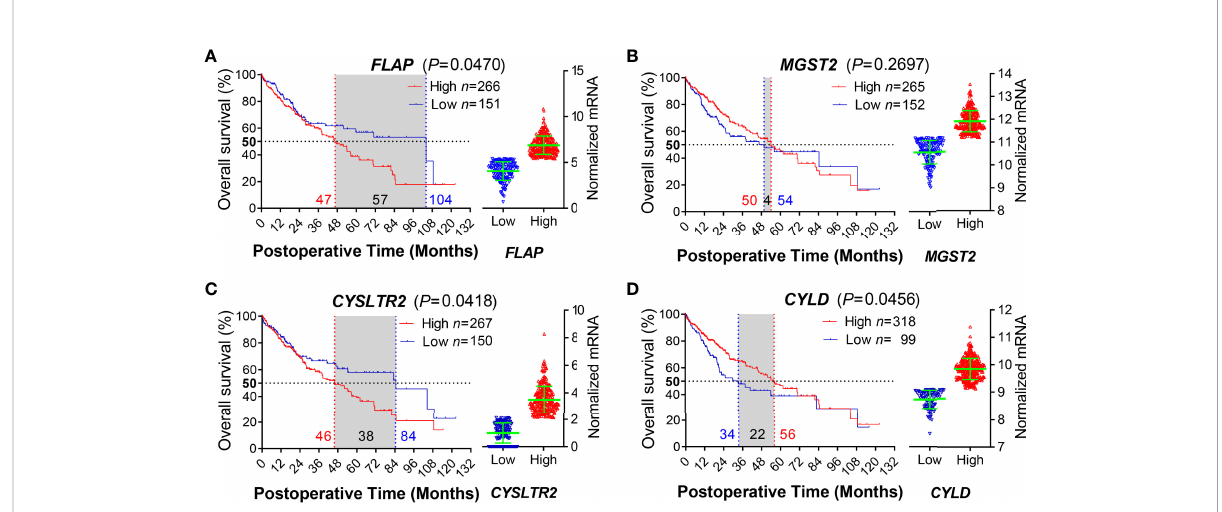
FIGURE 3 Enhanced hepatic FLAP mRNA shortens median survival time of HCC patients after surgical resection. Data for either HCC patients after surgical resection or liver transplantation from the TCGA Research Network (http://cancergenome.nih.gov/) were eligible for survival analysis. (A – D) Left panels: Kaplan – Meier survival curves in coordinate axis for comparing survival rates between high- and low-gene transcription subgroups from the HCC cohort. Horizontal dotted line: 50% survival. Vertical red/blue dotted lines: median survival time (MST). (A) FLAP mRNA ( p = 0.0470). (B) mGST2 mRNA ( p = 0.2697). (C) CysLTR2 mRNA ( p = 0.0418). (D) CYLD mRNA ( p = 0.0456). Right panels: Scattered plots of transcription levels for indicating genes from the HCC cohort. Student unpaired t- test was used to compare groups and p- value less than 0.05 was considered as statistically signi fi